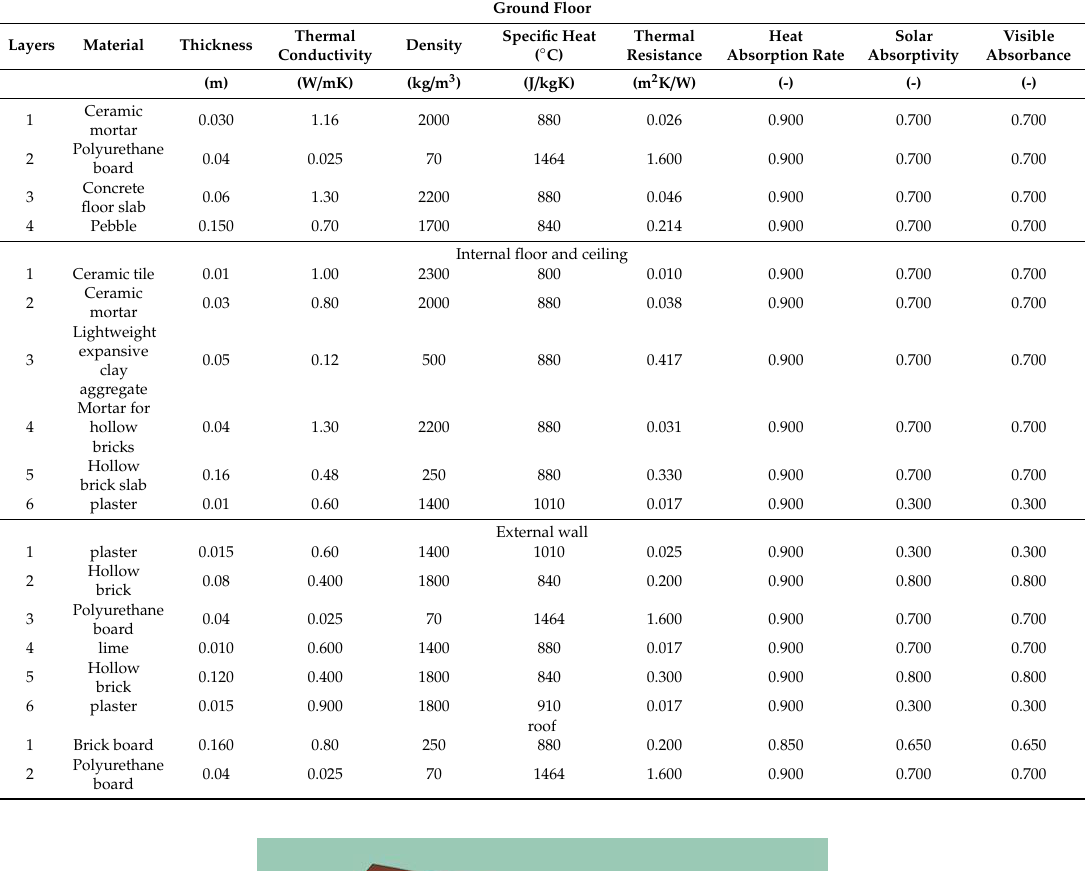
Table 4. Material parameters of building envelope.